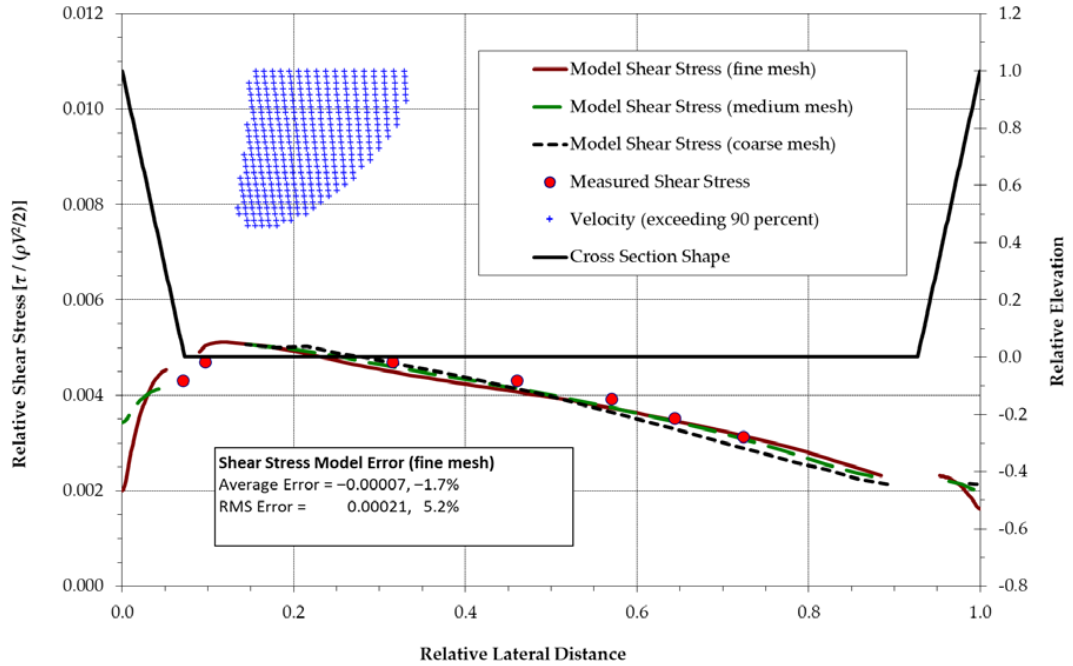
Figure 18. Comparison of simulated and measured shear stress for cross-section π / 4 (45 ◦ through the second channel curve). The channel cross section is also plotted along with the location of greatest velocity (within 90% of maximum velocity).